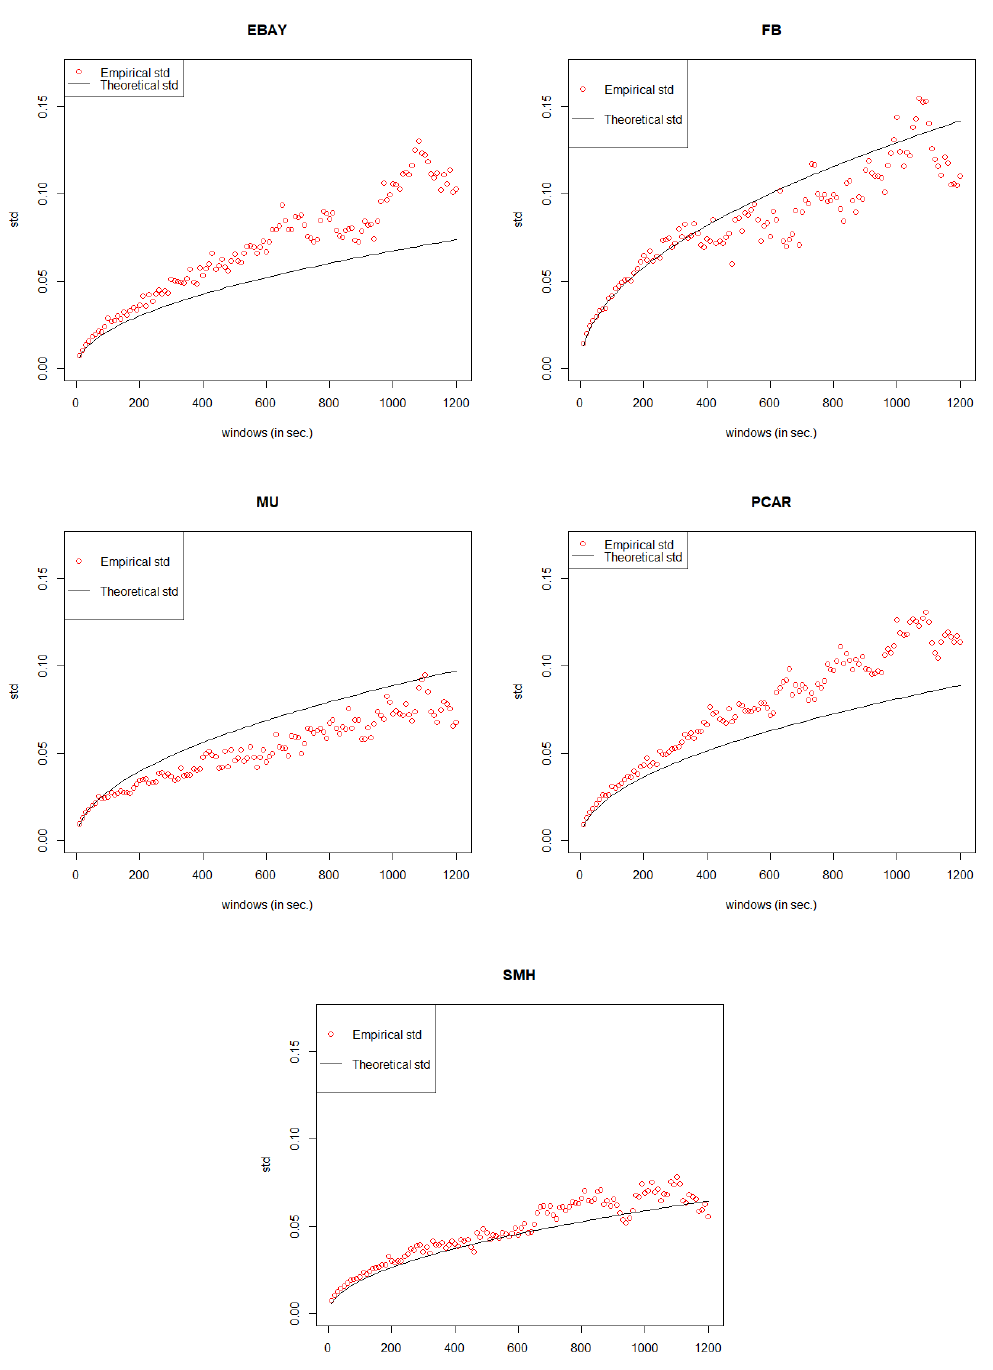
Figure 6. General Compound Hawkes Process with 2 non-fixed Dependent Oorder model fitting